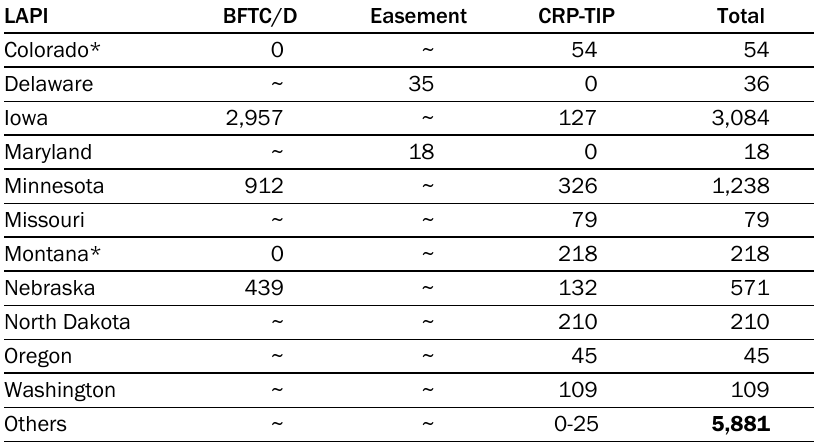
Table 2. Approximate Numbers of Incentive Contracts by State and Class of Land Access Policy Incentive